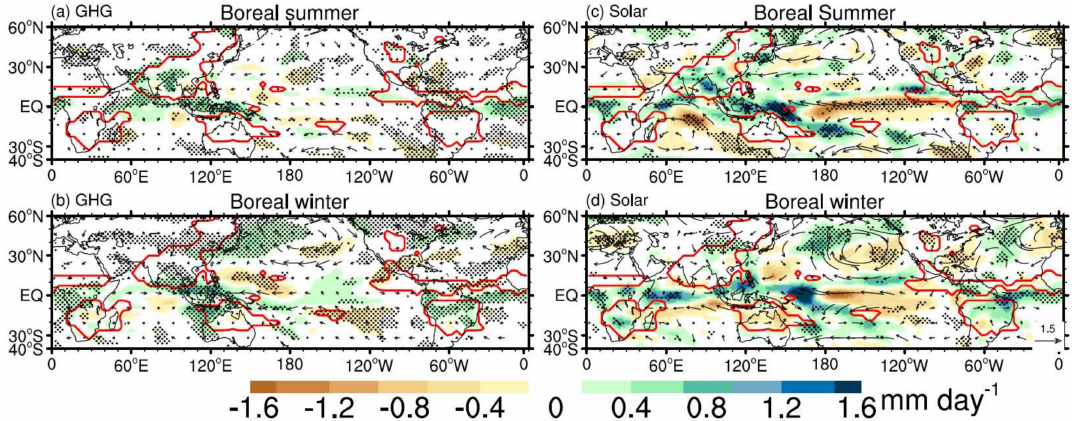
Figure 5. Horizontal distribution of precipitation change. Shown are the spatial patterns of the change of precipitation (shading) and the change of 850-hPa wind (vector) in boreal summer ( a , c ) and boreal winter ( b , d ) under the GHG ( a , b ) or solar ( c , d ) forcing between PWP and LIA. Each field is scaled to have the same global-mean temperature anomaly (PWP minus LIA) as the full forcing. Stippling indicates statistical significance (10% significance level) based on t